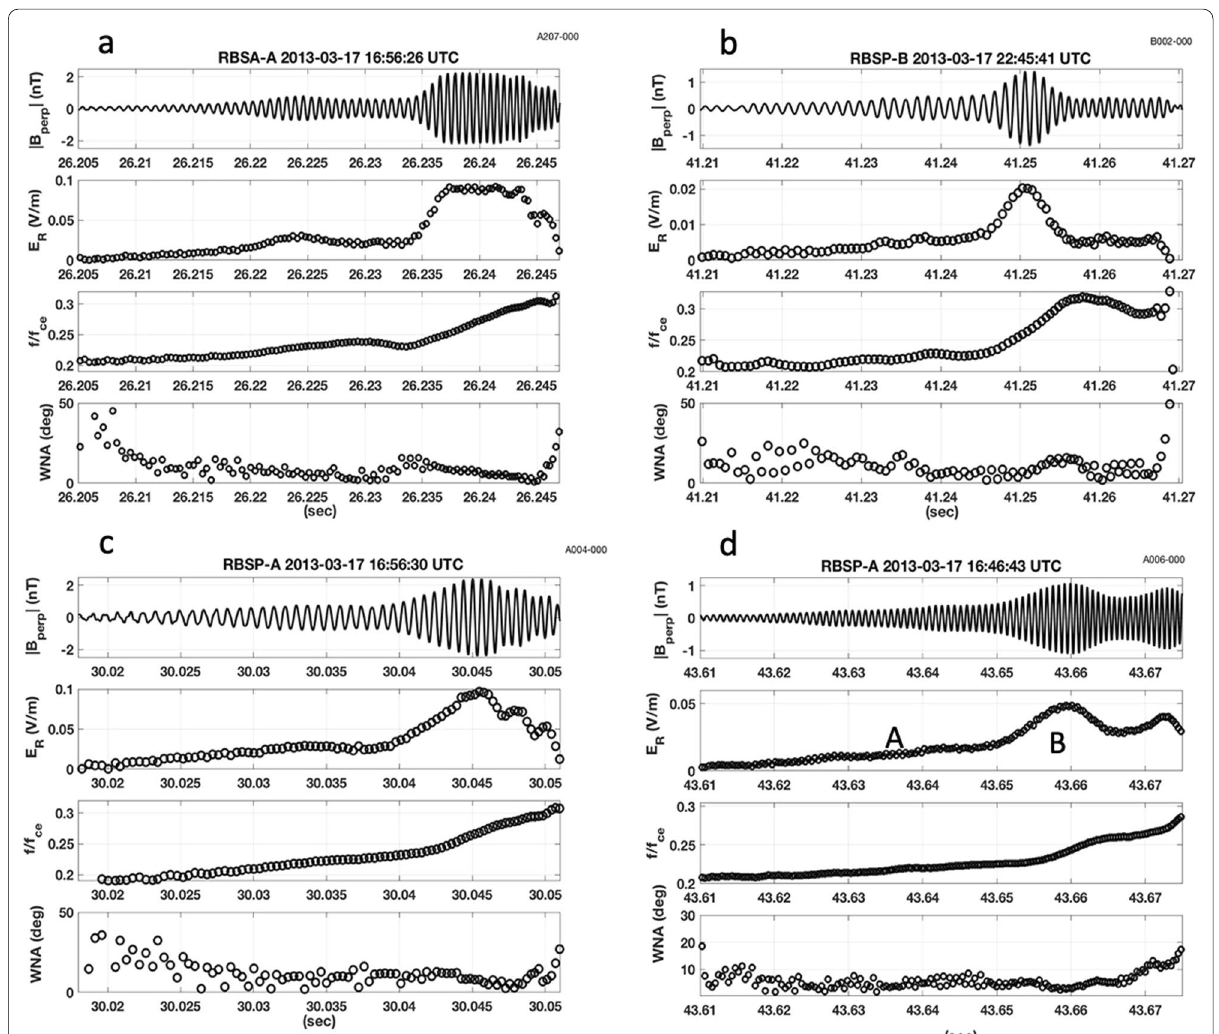
Fig. 2 Detailed observations of the initial two subpackets of four strong chorus wave elements recorded during the March 17, 2013 event are shown in panels a – d . See text for description. Panel b displays the analysis for the chorus element shown in Fig.